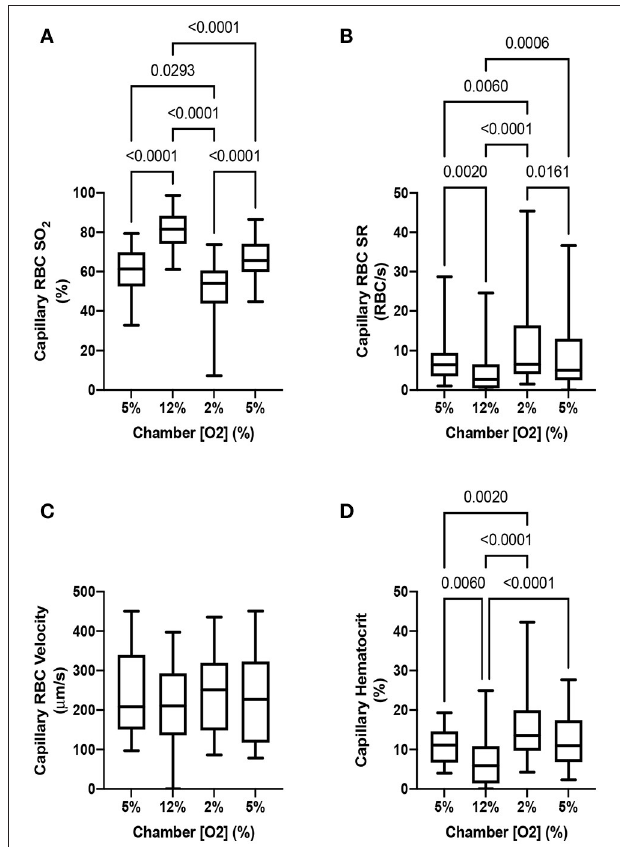
FIGURE 10 | Capillary hemodynamics and oxygen saturation responses in capillaries directly overlying exchange windows of the modular gas exchange platform. The platform imposed a square wave oxygen challenge from a baseline of 5% O 2 chamber oxygen concentration ([O 2 ]) followed by 2 min of 12%, 2 min of 2%, and 1 min of 5% with 5% CO 2 and balance N 2 . (A) shows the capillary red blood cell (RBC) oxygen saturation (SO 2 ) in the last 30s of each imposed chamber [O 2 ] across 14 fields in 4 animals ( n = 24 capillaries). The resulting blood flow response to the change in SO 2 is illustrated by the capillary RBC supply rate (SR) and hematocrit changes shown in (B,D) ( n = 32 capillaries). Changes in capillary RBC velocity (C) were not found to be significant between any chamber [O 2 ] ( n = 29 capillaries). p values based on Tukey’s multiple comparisons test after significant repeated measures ANOVA (capillary RBC SO 2 ), and Dunn’s multiple comparisons test after significant Friedman test (capillary RBC SR and hematocrit) are indicated in the figure with a p < 0.05 considered to be significant. Box and whisker plots show minimum, median, maximum, and associated